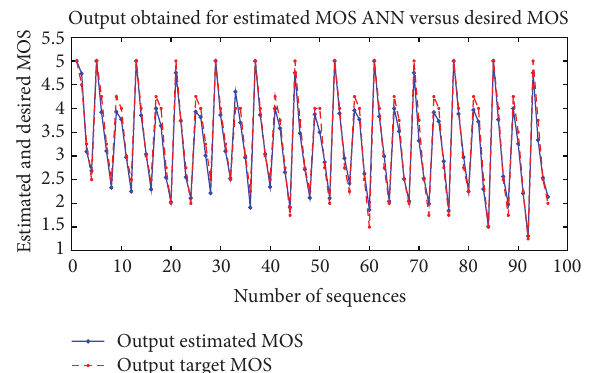
Figure8:Resultsoftheoutput,estimatedMOSversusdesiredMOS.